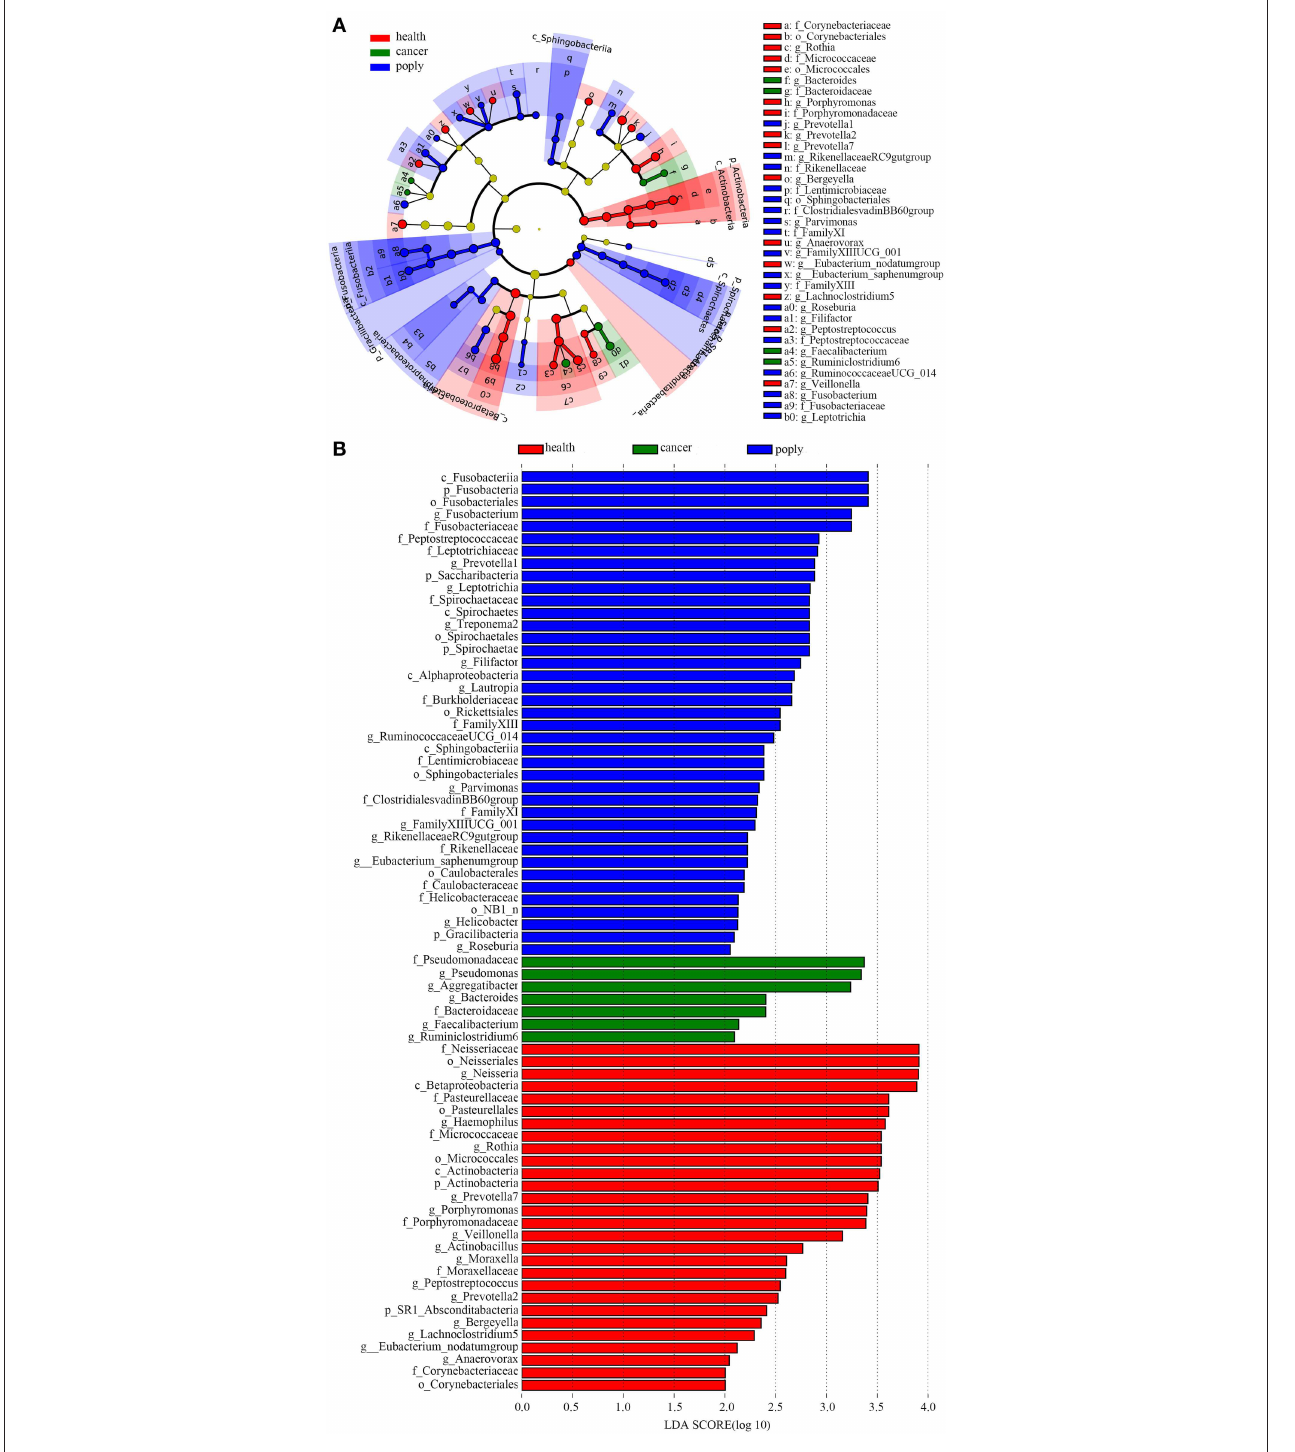
FIGURE 4 | Identification of diagnostic markers for throat cancer following LDA of throat cancer and microbial taxa. (A) Cladogram representation of the oral microbiota taxa in the throat cancer, vocal cord polyp, and normal control groups. (B) Specific microbiota taxa in throat cancer patients following LDA. Green indicates taxa enriched in the throat cancer group, red indicates taxa enriched in the vocal cord polyp control group, and blue indicates taxa enriched in the healthy group.